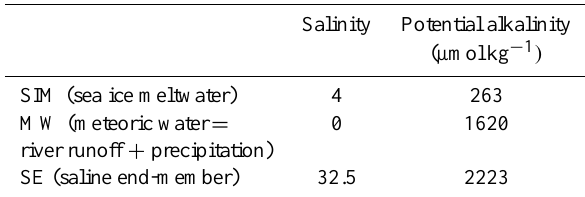
Table 2. R/V Mirai survey periods. Table 3. End-member values used in this